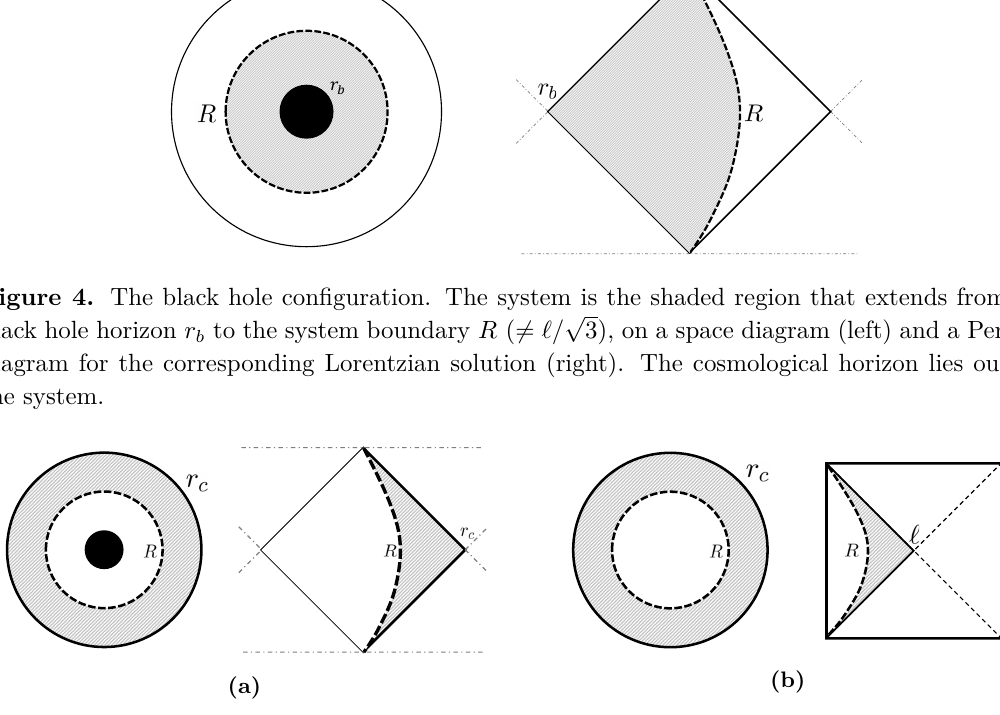
Figure 5. The cosmological configurations, when the mass parameter is positive (a) or zero (b). The system is the shaded region, in either the space diagram (left) or the corresponding Lorentzian Penrose diagram (right). For a given temperature, the mass parameter of the stationary point in (a) is different from the one in figure 4, so a given SdS space is not both a b-horizon and a c-horizon stationary